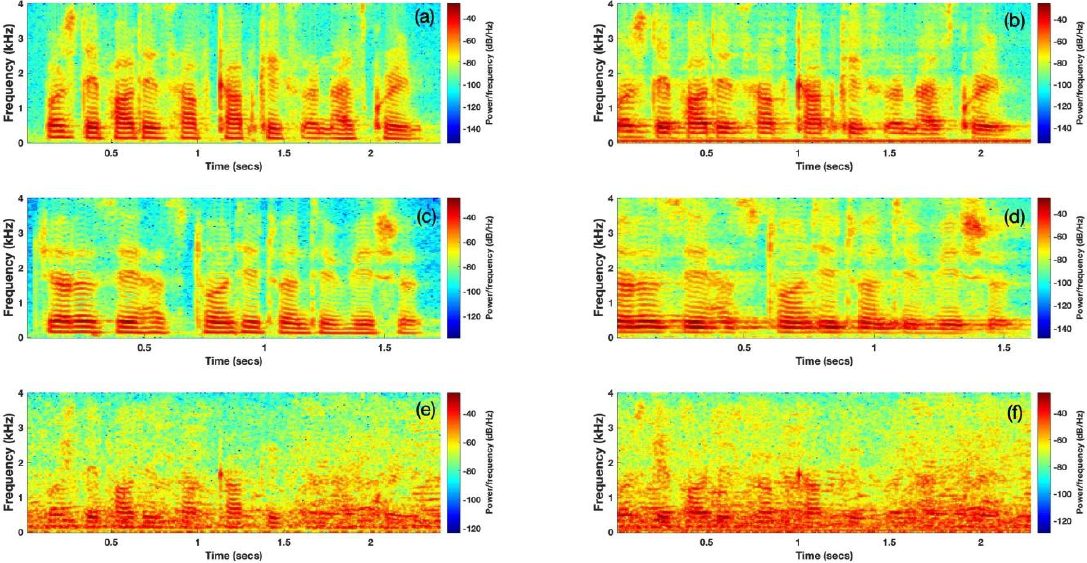
Figure 1. Spectrogram of genuine and replay utterances. ( a , c ) are genuine human voices while ( b , d ) are replay recordings of ( a , c ), respectively. Spectrograms ( e , f ) are the noise contaminated versions of ( a , b ), respectively, where babble noise with 0 dB signal-to-noise ratio (SNR) was added. (1) The durations of the utterances are di ff erent. Hence, the chosen algorithm should be able to process signals with variable